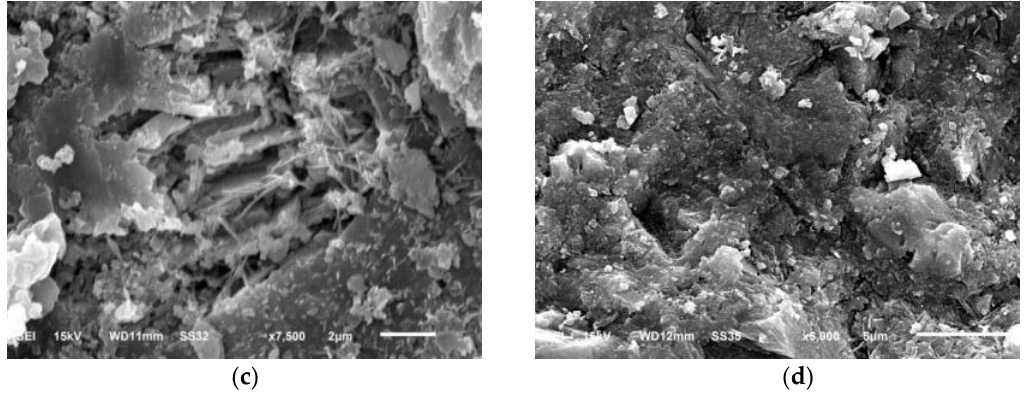
Figure 11. SEM images: ( a ) control cement at three days ( b ) cement with nano-SiO 2 3% at three days ( c ) control cement at 28 days; and ( d ) cement with nano-SiO 2 3% at 28 days.